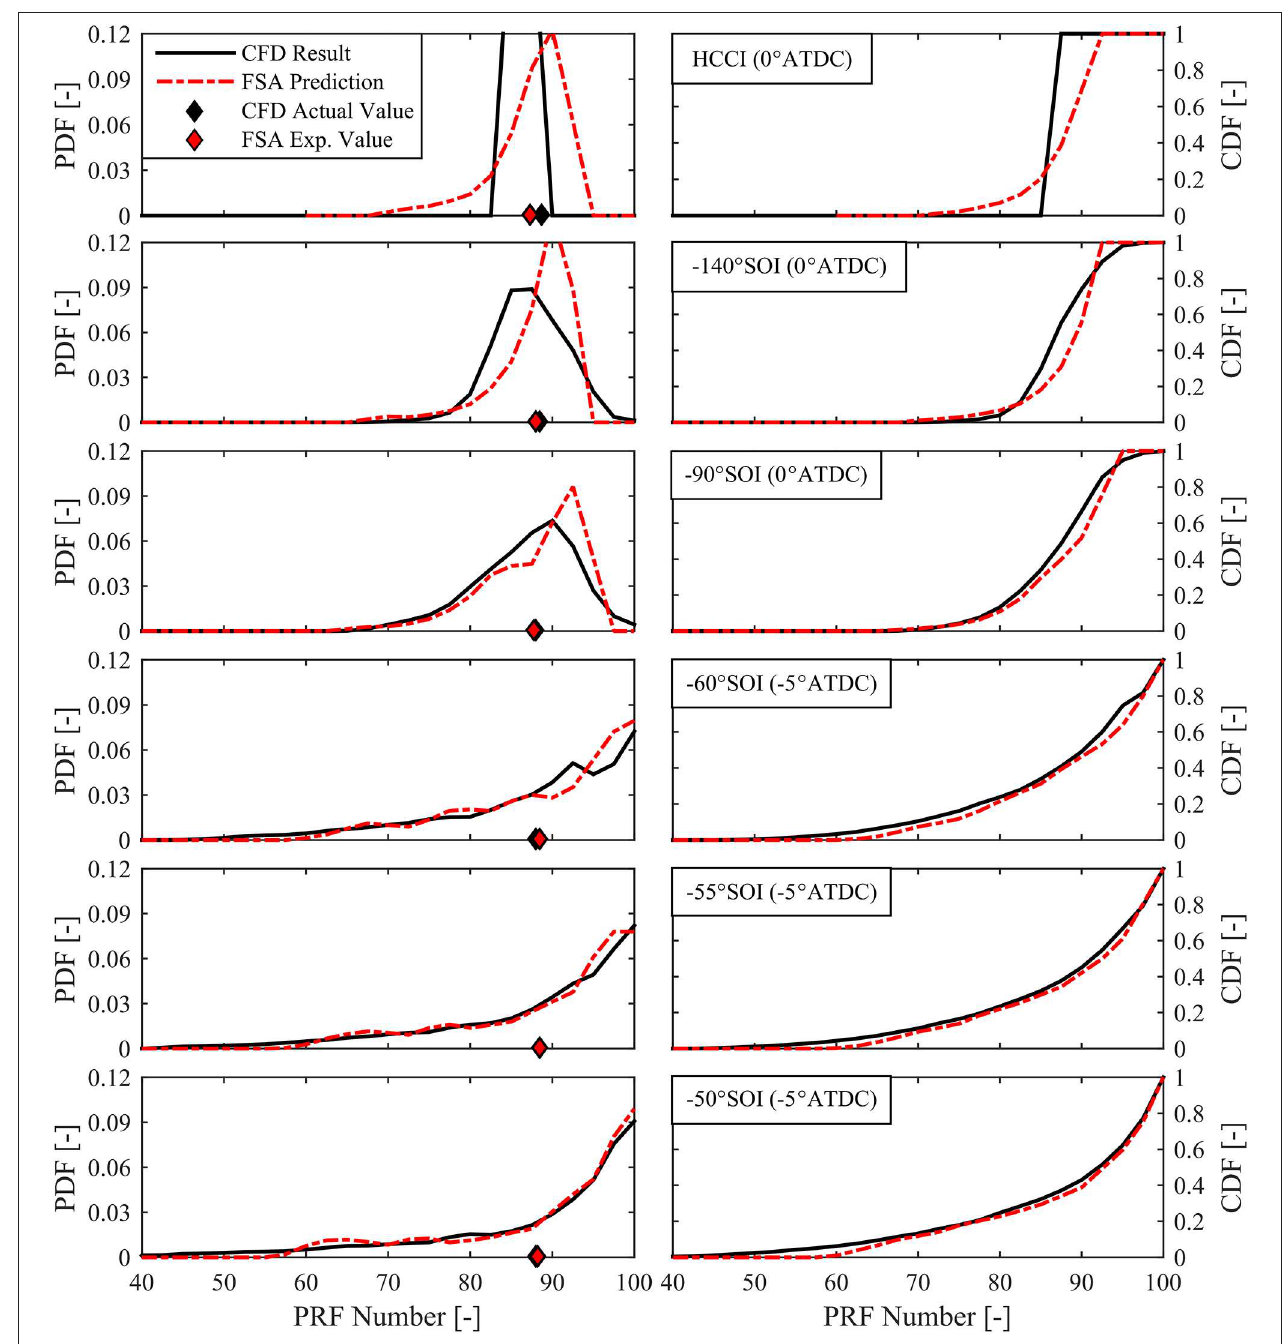
FIGURE 10 | PDFs (Left) and CDFs (Right) vs. PRF Number for non-reacting CFD at specified crank angle for specified SOI case from HCCI to − 50 ◦ , compared to normalized FSA method predicted